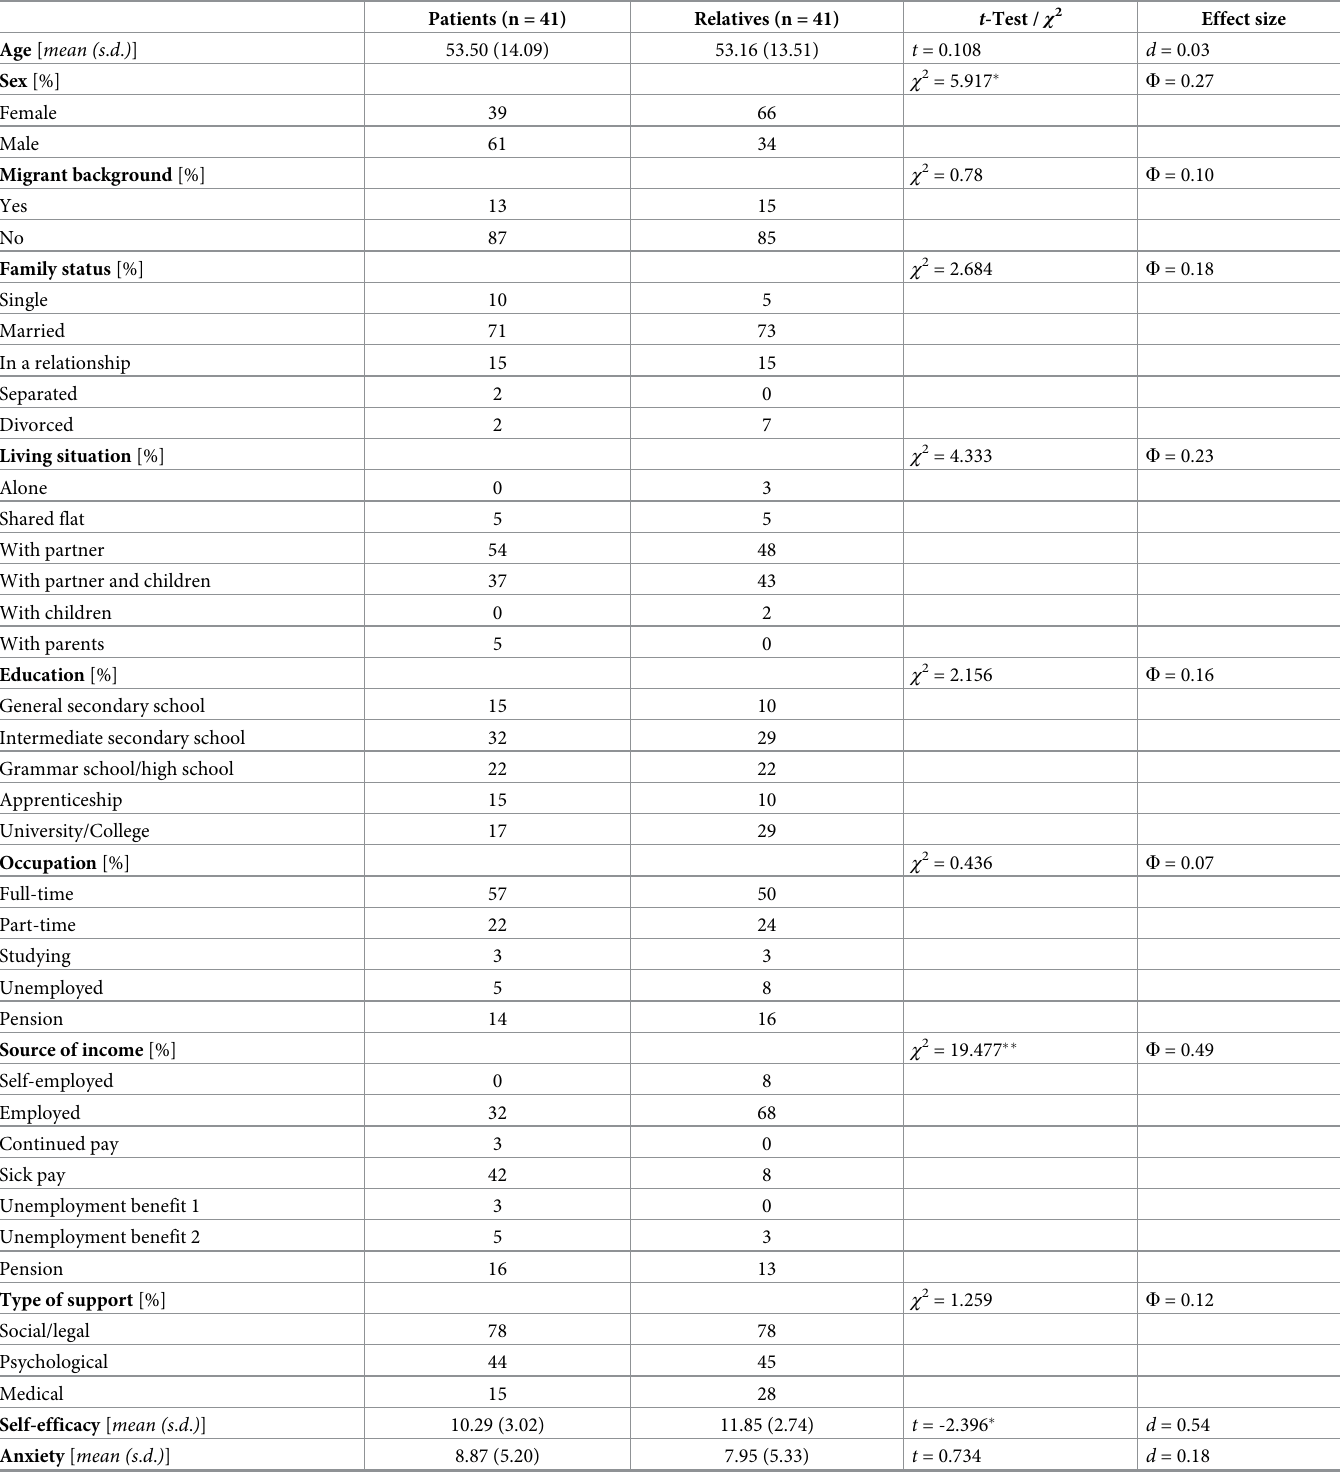
Table 1. Differences between patients and